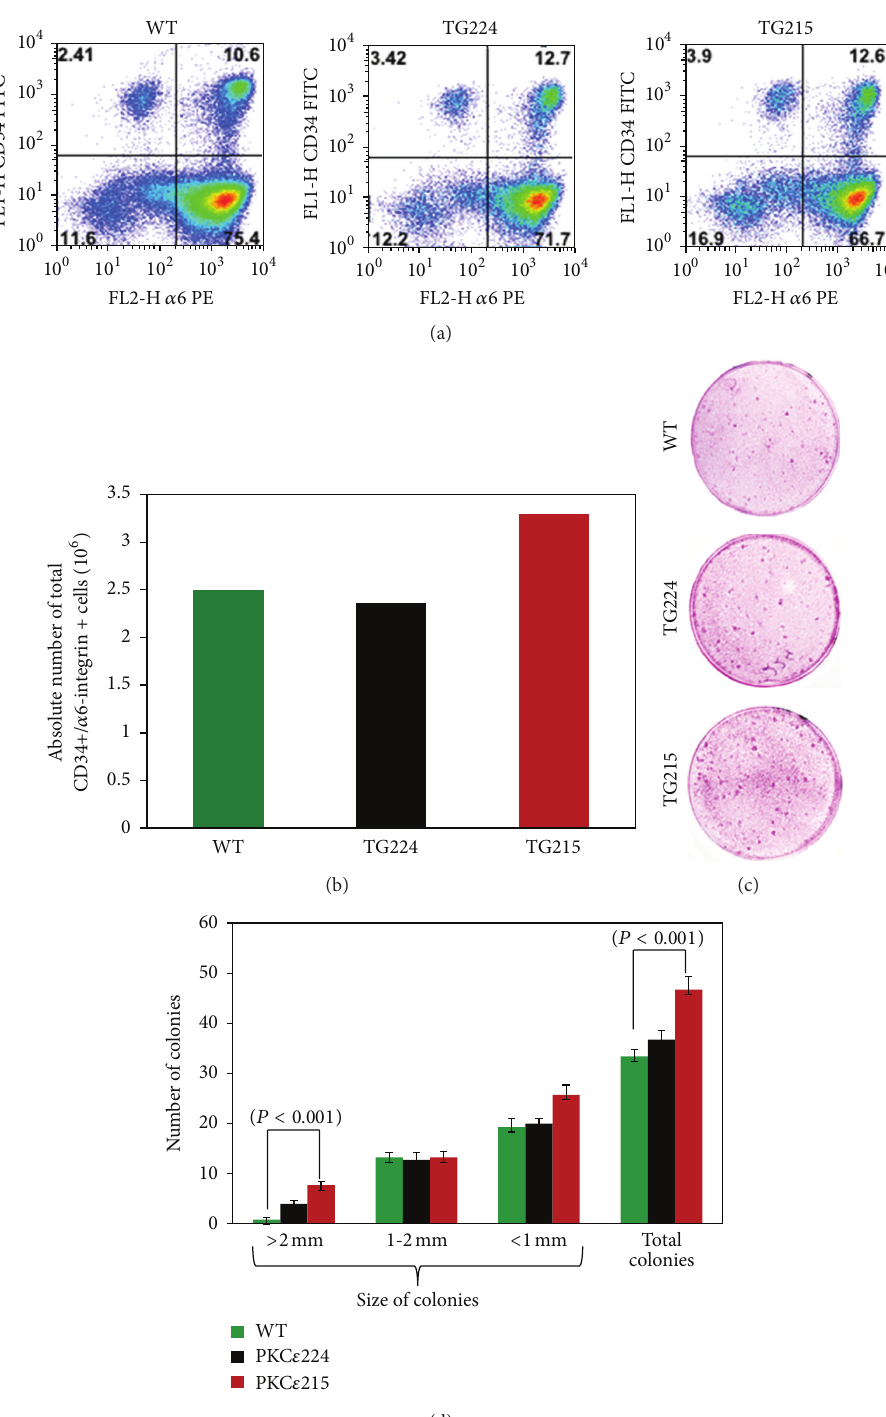
Figure 1: Hair follicle stem cells and clonogenicity of epidermal keratinocytes isolated from PKC 𝜀 overexpressing mice and wild-type littermates. (a) is showing the representative gating of epidermal stem cell population in a dot plot from untreated WT, TG224, and TG215 mice. In each dot plot, the upper right quadrant is representing the CD34+/ 𝛼 6-integrin+ (double positive HSCs) stem cell population. Each value in the histogram is an average of FACS analysis of triplicate samples from keratinocytes pooled from two mice. (b) represents the total frequency of CD34+/ 𝛼 6-integrin+ keratinocytes in untreated indicated mice. (c) and (d) Clonogenicity of epidermal keratinocytes. Briefly, the keratinocytes from 7-8 weeks old indicated that mice were harvested using SMEM harvesting medium. Irradiated 3T3 cells seeded at density 10 6 cells/dish to the 60mm dishes a day before seeding keratinocytes. For feeder layer, irradiated 3T3 cells were cultured in EMEM medium with 10% FBS and 1% penicillin-streptomycin. Equal numbers of keratinocyte cells (3000 cells/dish) were seeded for each type of mice and cultured with William’s E media for 2 weeks. For counting and measurement of colonies, dishes were fixed with 10% formalin and stained with 0.5% rhodamine B. (c) Keratinocyte colonies. Shown are the representative dishes of adult keratinocyte colonies from PKC 𝜀 TG mice and their WT littermates. (d) Quantitation of colonies. The colonies were counted and colony size measured by using vernier caliper (Figure 1(c)). Each value is the mean ± SE of colonies from 4–7